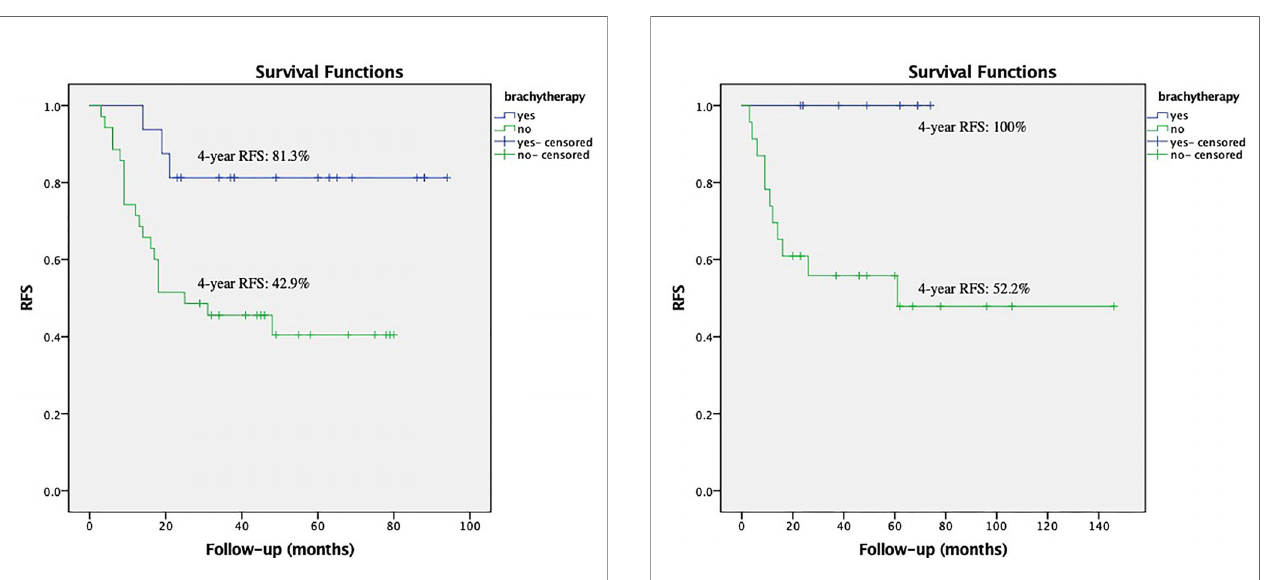
FIGURE 1 | Recurrence Free Survival (RFS) with or without vaginal cuff brachytherapy in patients with a bulky mass and deep stromal invasion. The 4-year RFS was 81.3% vs. 42.9%, respectively, P = 0.012.